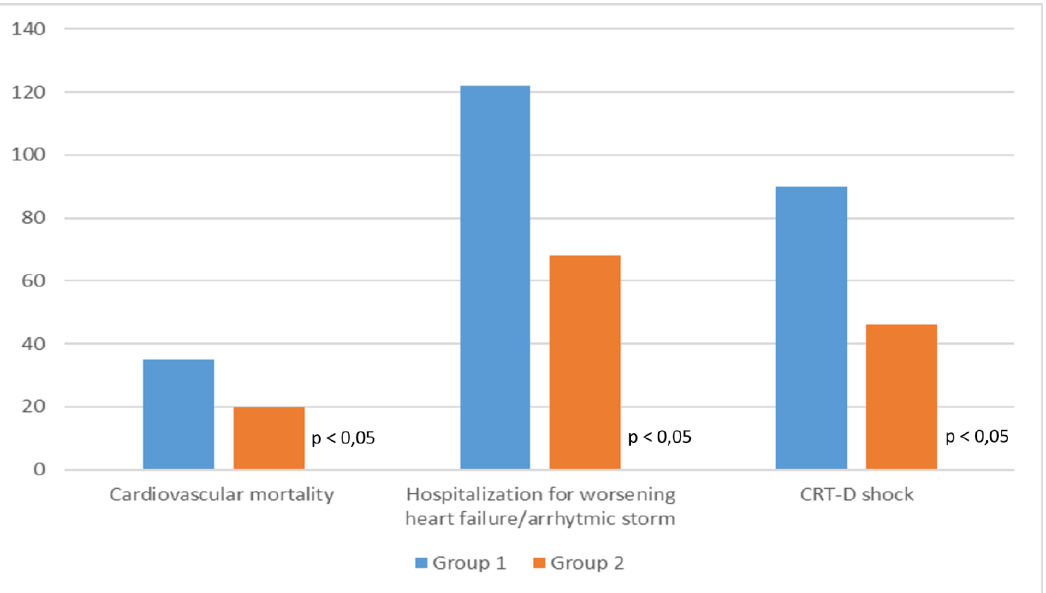
Figure 1. Clinical outcome of the two study groups.